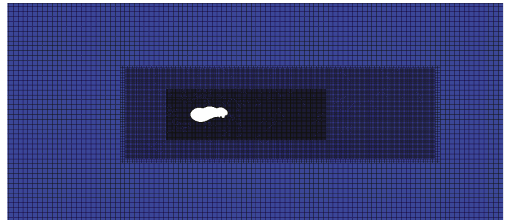
Figure 8: Optimized computation model of asymmetric cross- section rod.